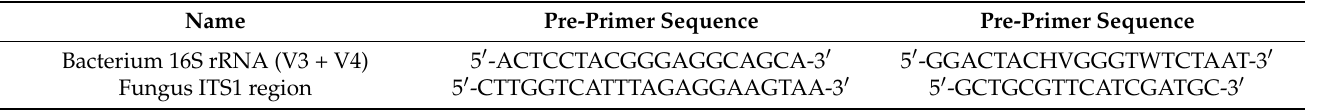
Table 2. Detailed information on bacterial and fungal primers used in this